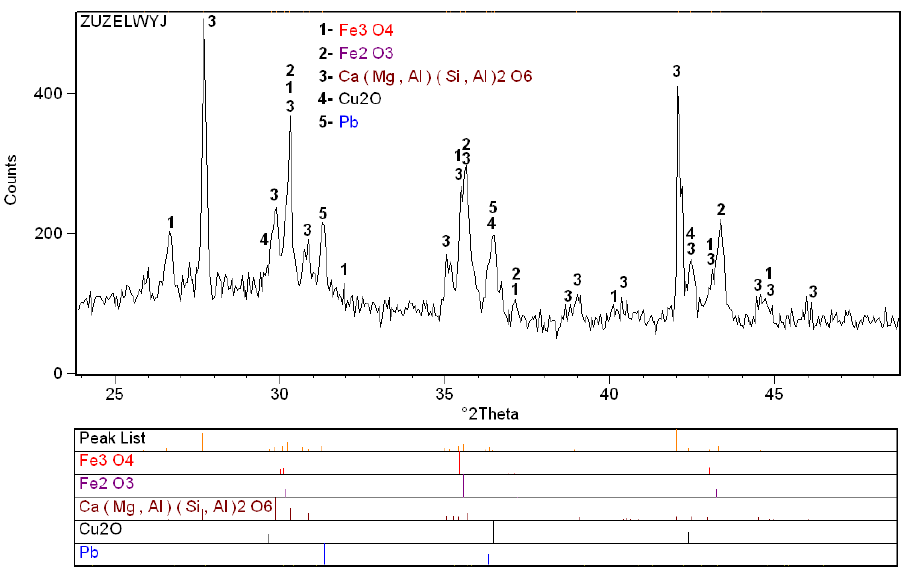
Figure 5. XRD of the initial slag [43].